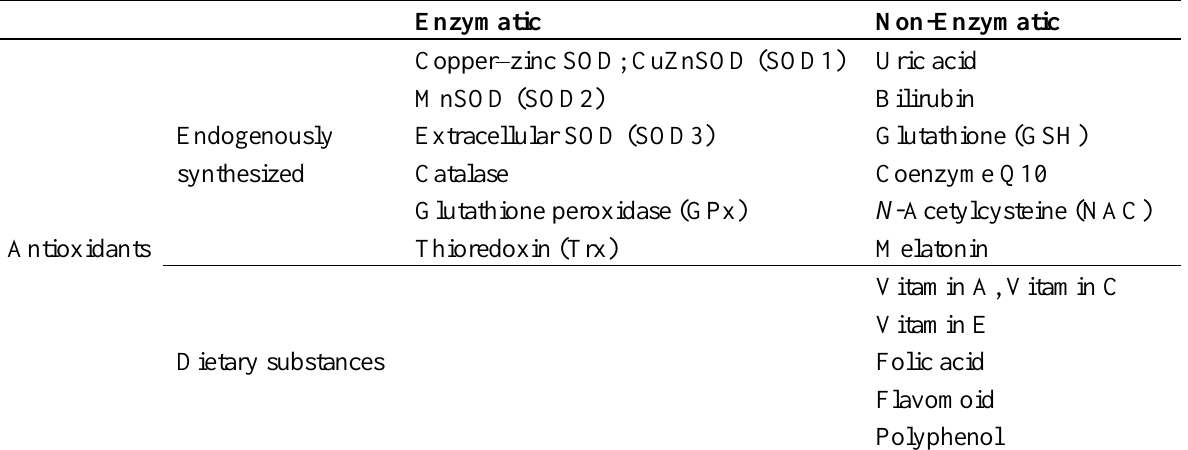
Table 1. Summary of major enzymatic and non-enzymatic antioxidants in